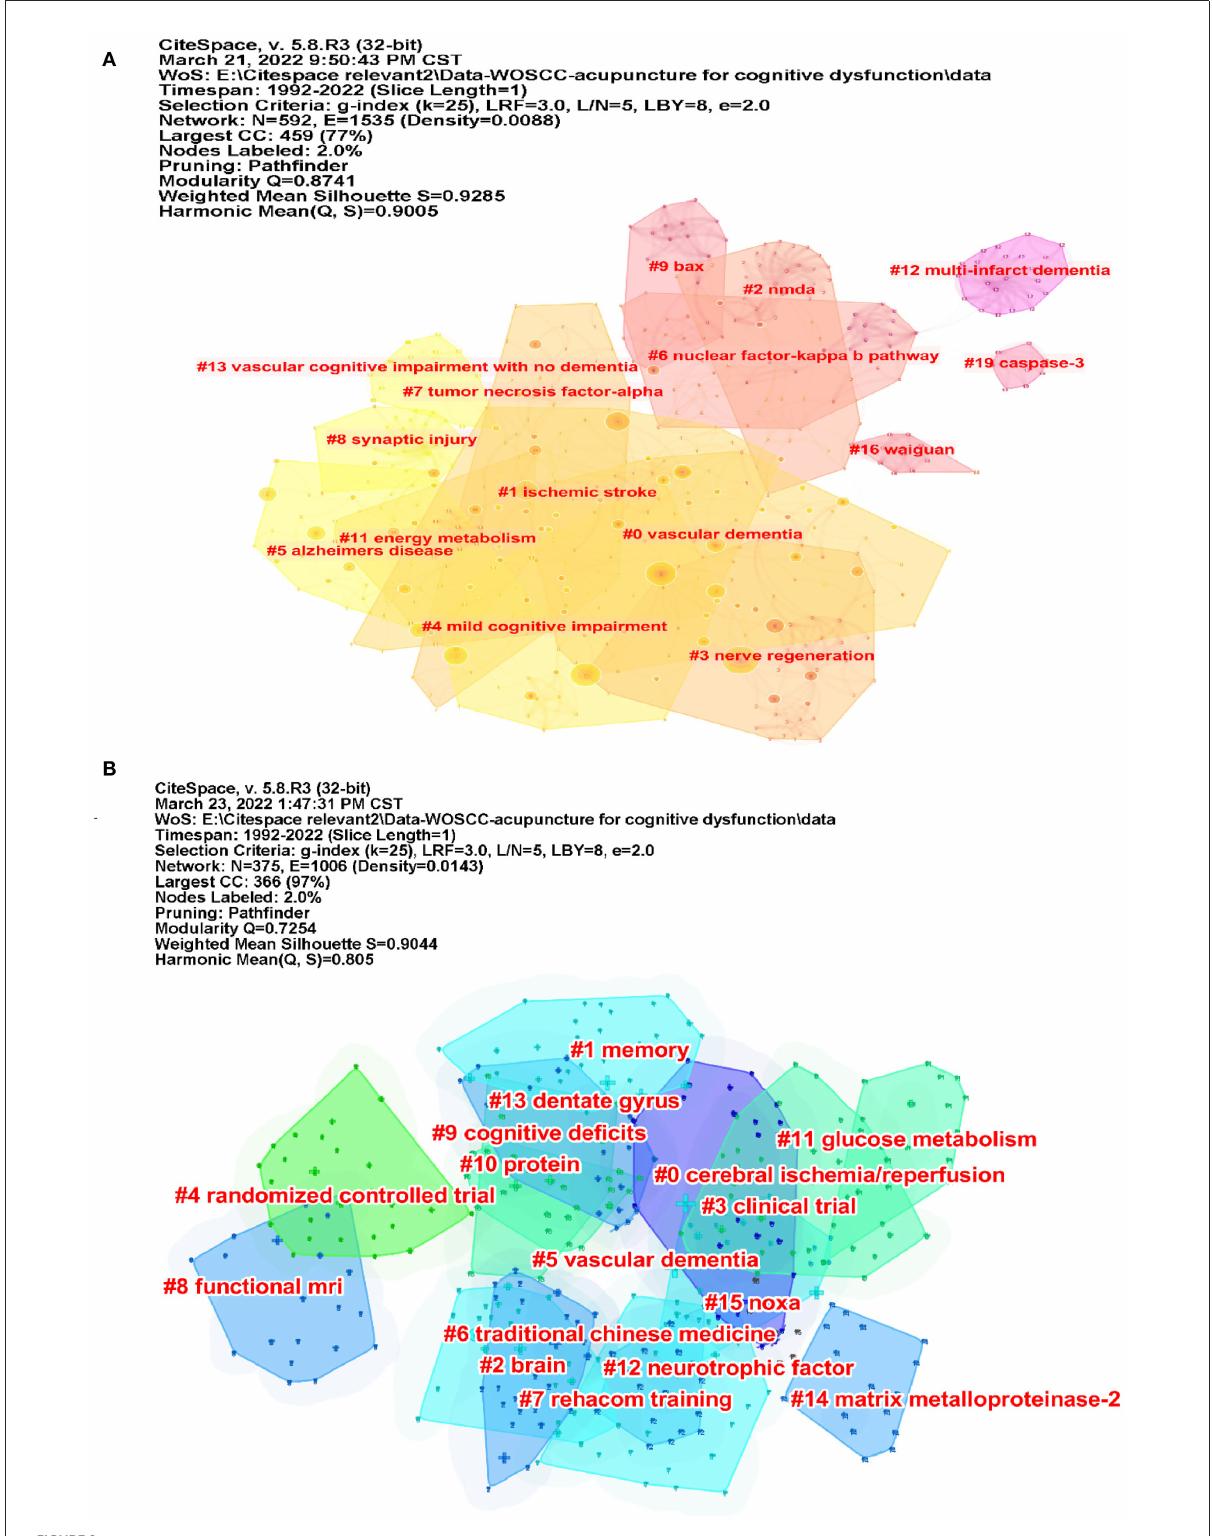
FIGURE9 The co-cited reference and keyword clusters map for publications. (A) The co-cited reference clusters map for publications and (B) the keyword clusters map for publications. In clustering, the same elements would be aggregated together, each cluster existed independently, and the cluster label is a name for each cluster